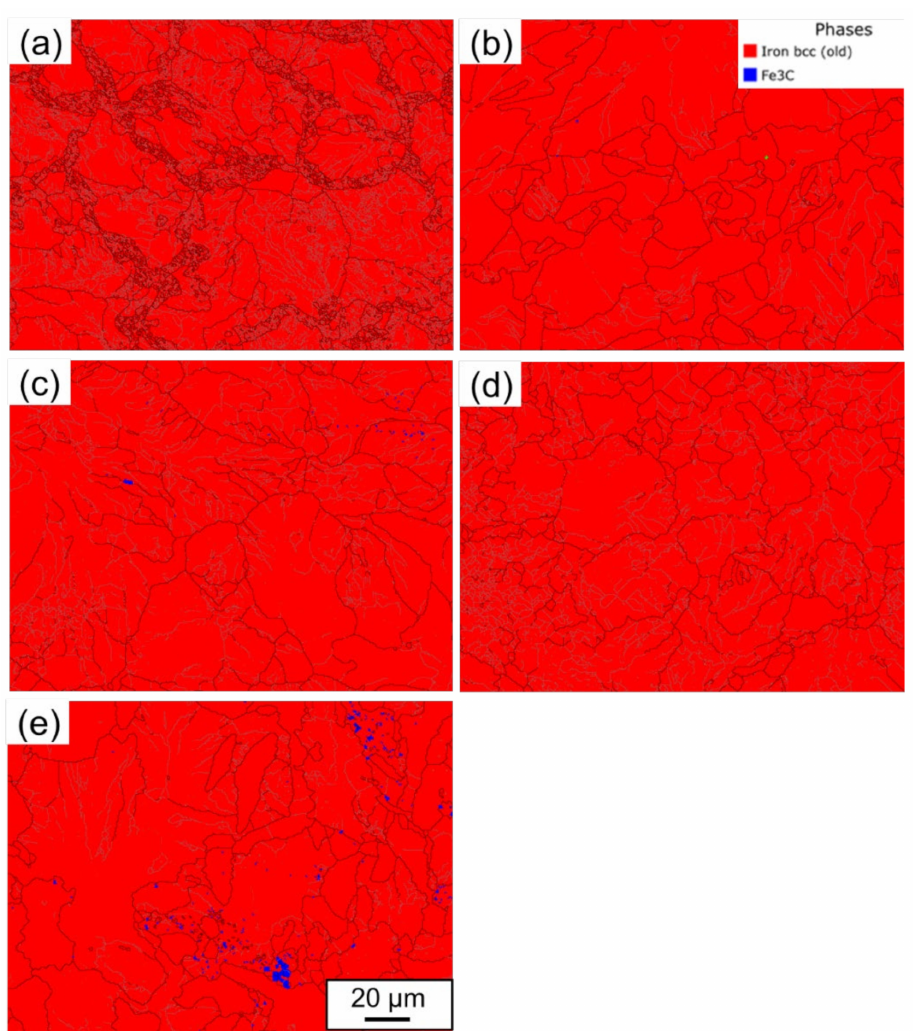
Figure 2. Phase images of microstructures for the rail steels: ( a ) 1904, ( b ) 1911, ( c ) 1917, ( d ) 1919, ( e )